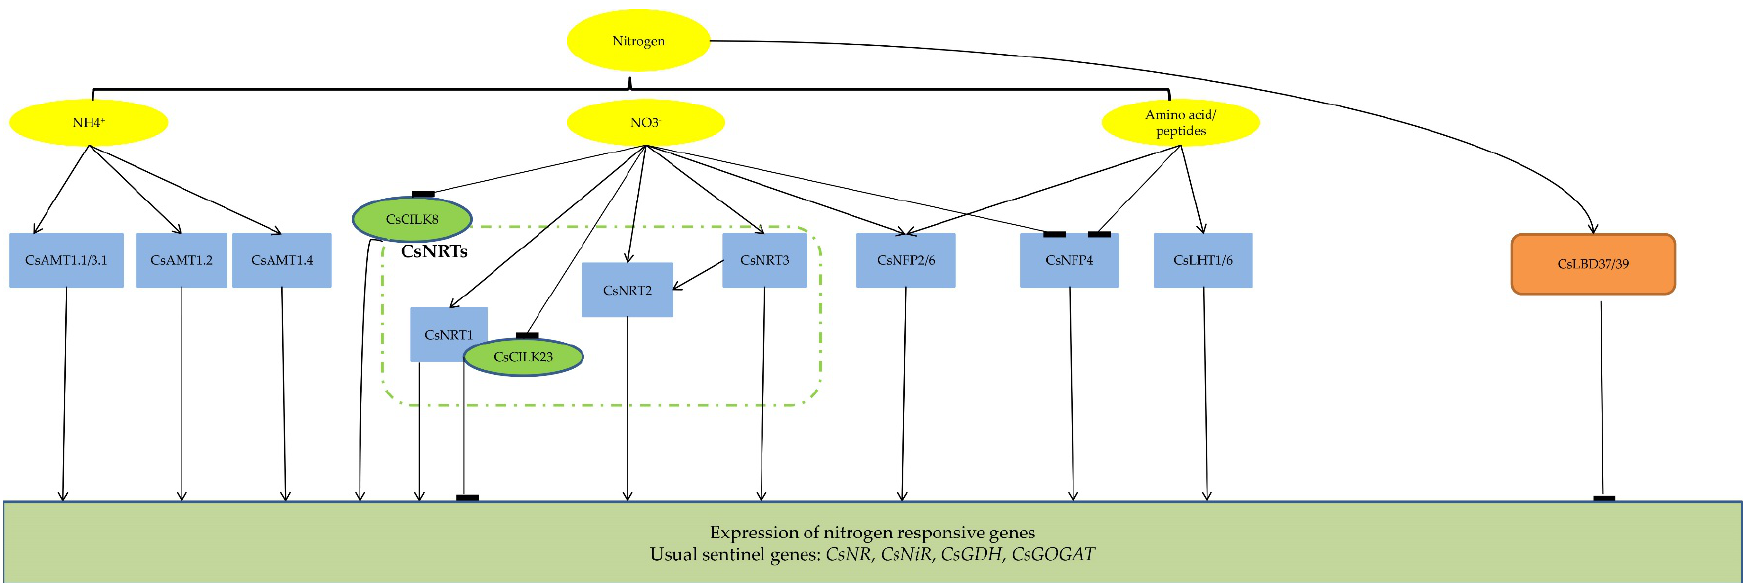
Figure 1. Schematic representation of some genes involved in the nitrogen response under different nitrogen forms (ammonium, nitrate, amino acid and peptides). The yellow box indicates nitrogen or a nitrogen form; the blue box indicates a nitrogen transporter factor; the orange box indicates protein kinases; the green box indicates a transcription factor; the light green dashed box indicates CsNRT genes family ( CsNRTs ). Arrow indicates positive regulation; blunted line indicates negative regulation.